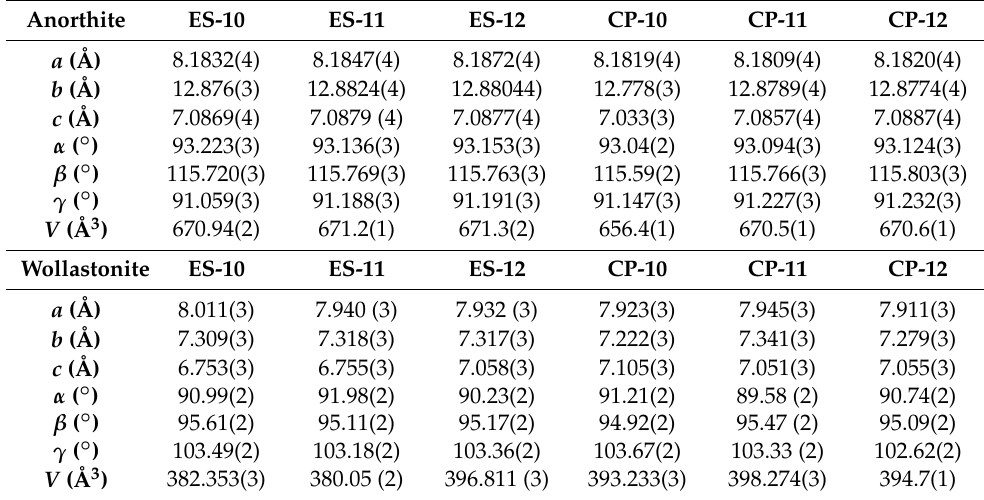
Table 5. Unit-cell parameters of the main breakdown products after the heat treatment of epidote (ES) and clinozoisite (CP).